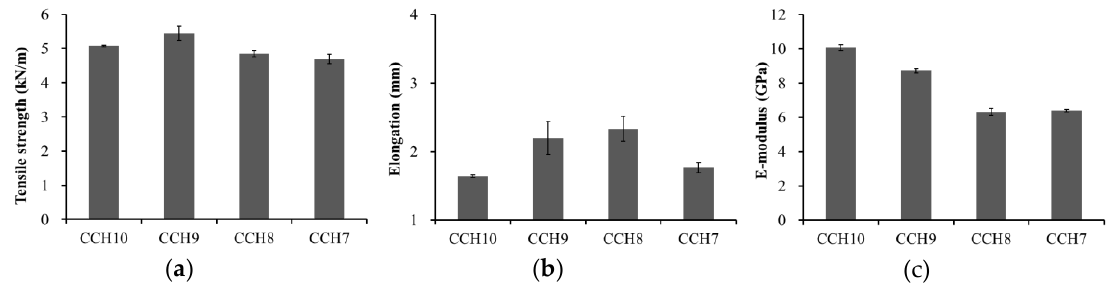
Figure 4. Tensile strength ( a ), elongation ( b ), and E-modulus ( c ) of the CCH films.